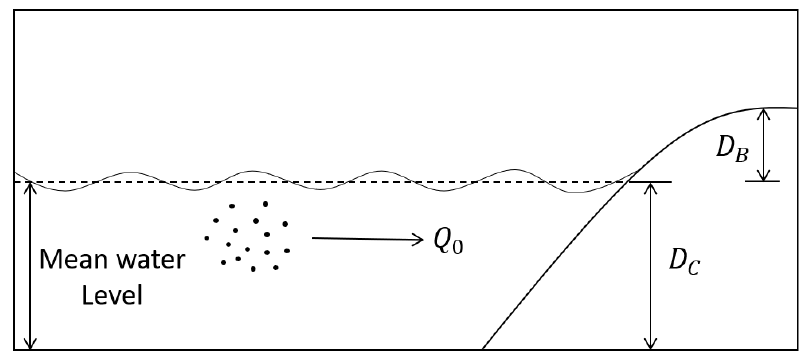
Figure 2. Shoreline’s physical